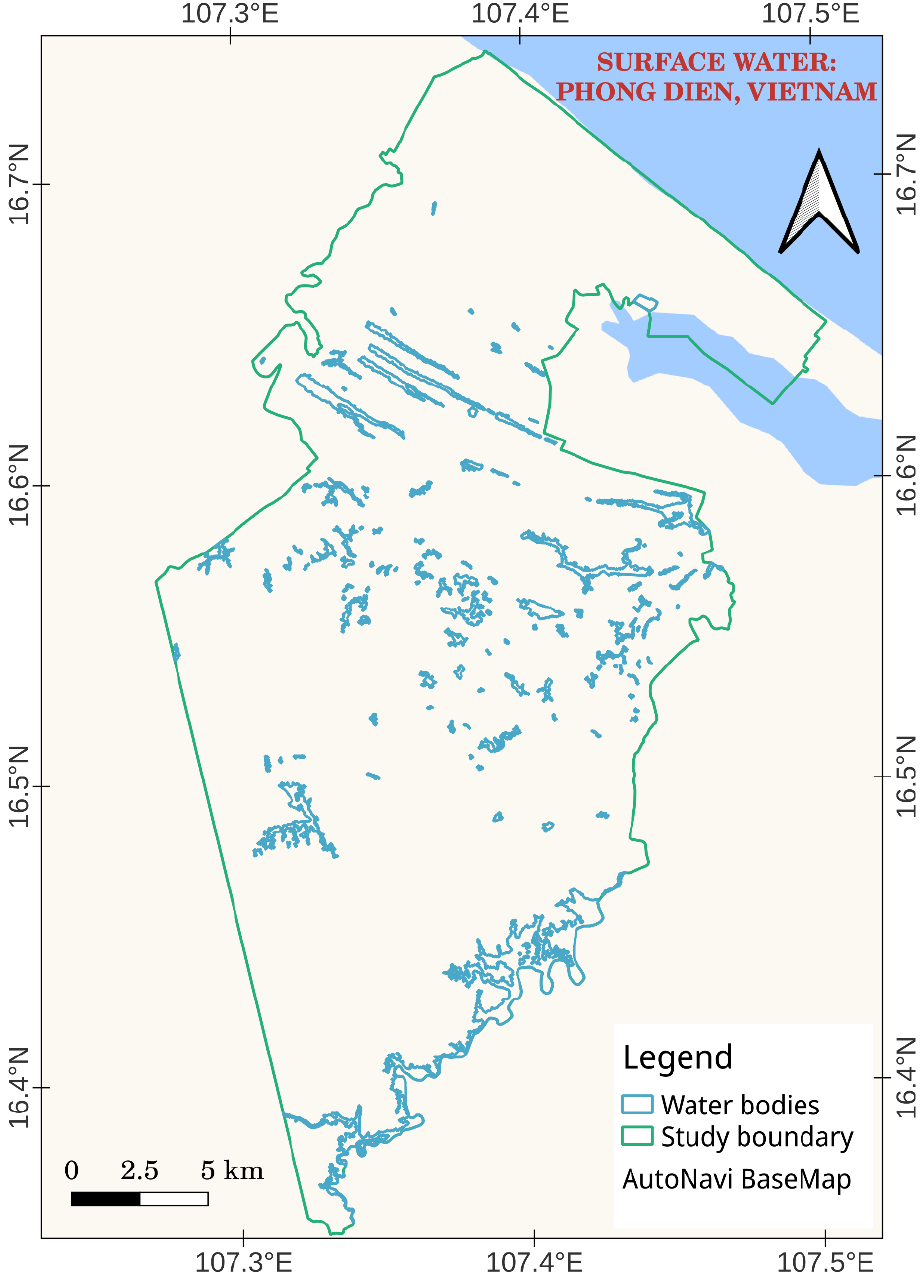
Figure 3. Water bodies extracted from Sentinel-1 imagery with the K-Means clustering.